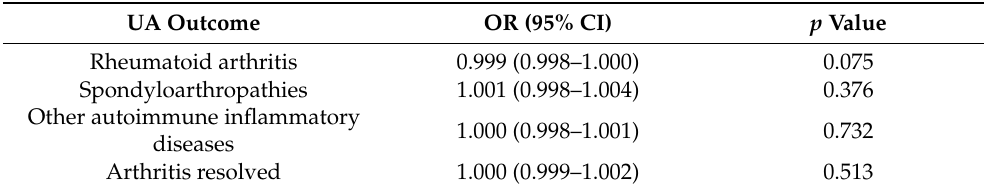
Table 11. Association between early undifferentiated arthritis study cohort outcomes and VEGF